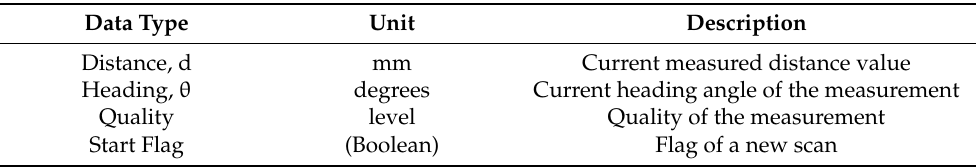
Table 2. The RPLIDAR A1 Sample point data information.